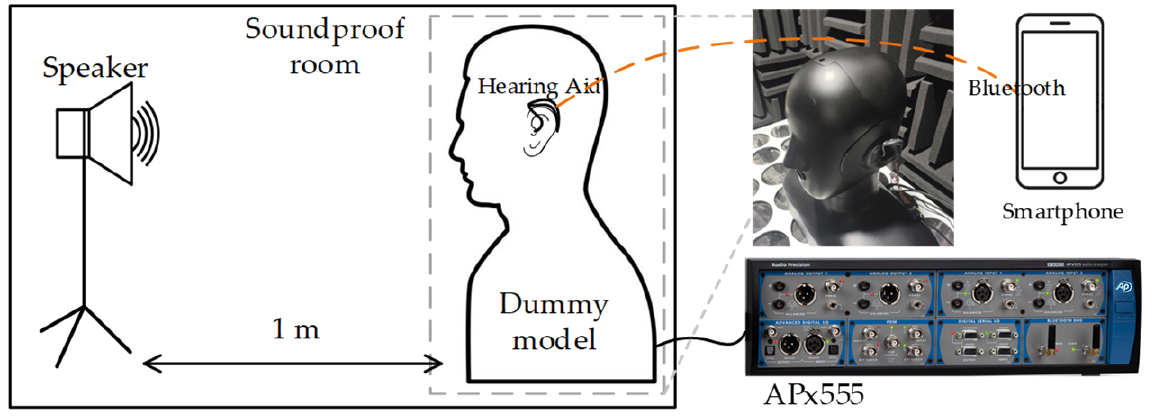
Figure 9. Performance test scenario for acoustic feedback cancellation.